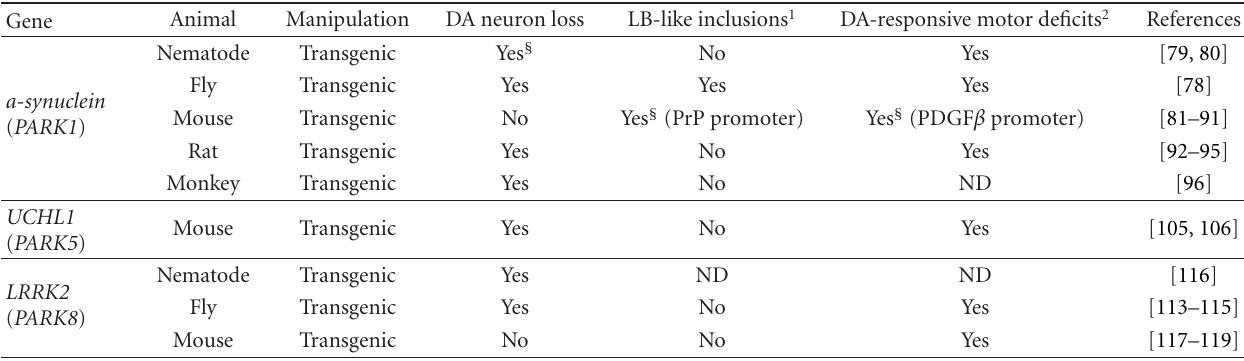
Table 2: Autosomal-dominant PD models.